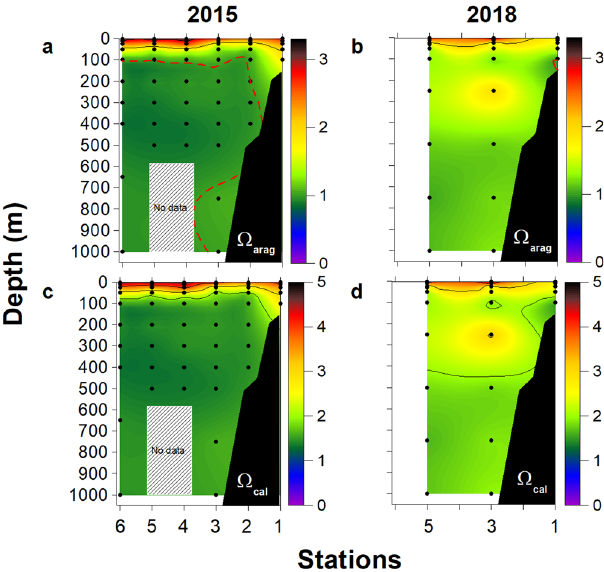
Fig. 5 Calcium carbonate saturation state during both research cruises. Vertical cross-shelf sections of ( a , b ) aragonite saturation state ( Ω arag ) and ( c , d ) calcite saturation state ( Ω cal ) during research cruises in 2015 and 2018. The dotted red line for Ω values represents the isopleths of 1; below such value is considered CaCO 3 undersaturation. The black dots represent sample locations. Gray box represents an area with non-collected